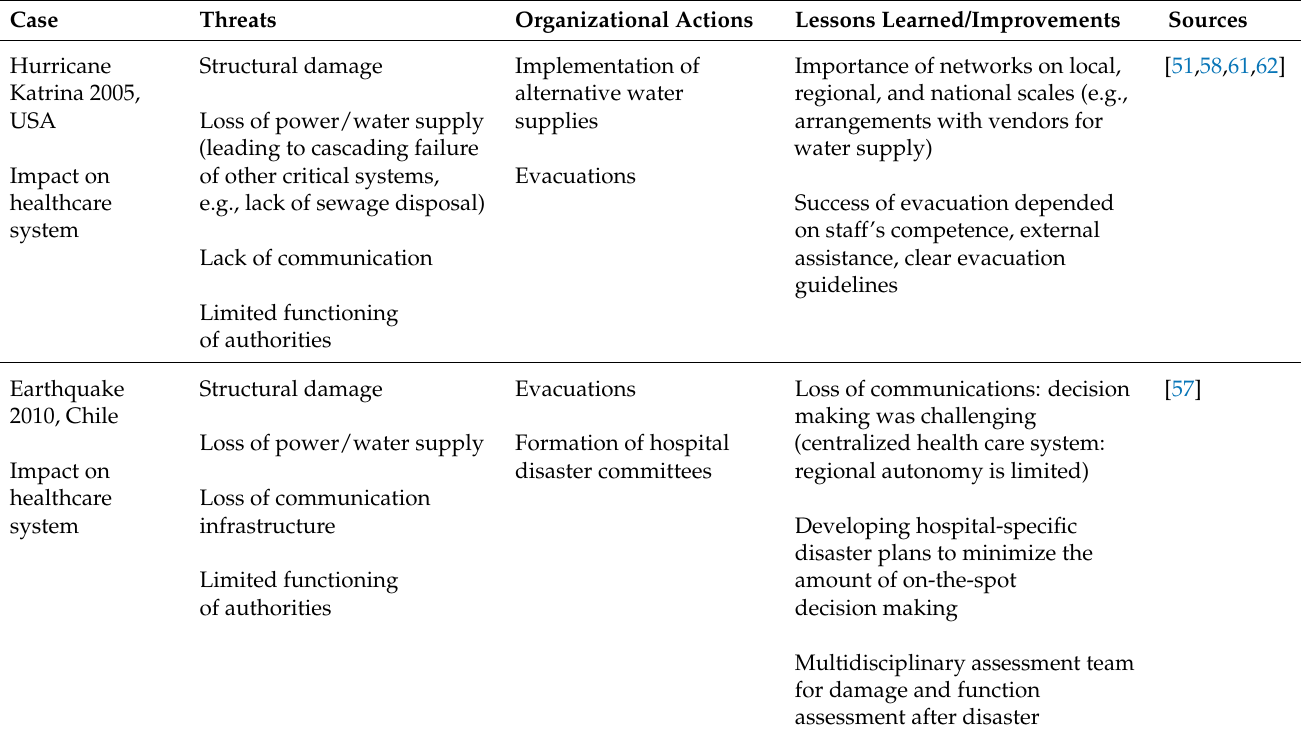
Table 2. Overview of selected real-world cases, including threats, organizational actions in response, lessons learned, and improvements implemented after the